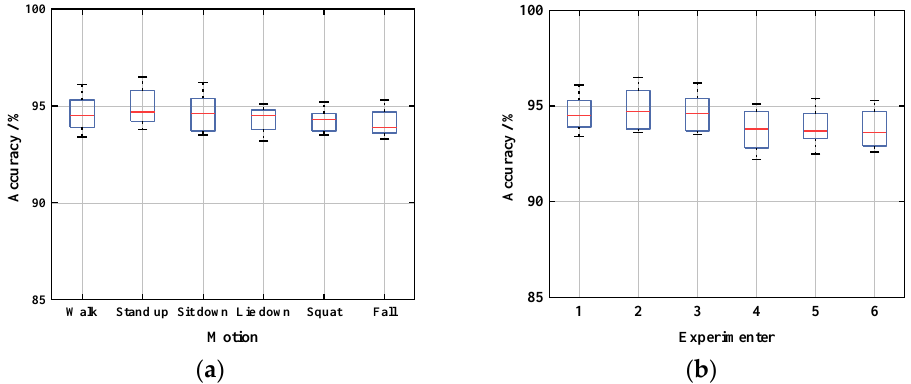
Figure 12. Impact of user diversity: ( a ) different movements of the same person; ( b ) the same action for different people.